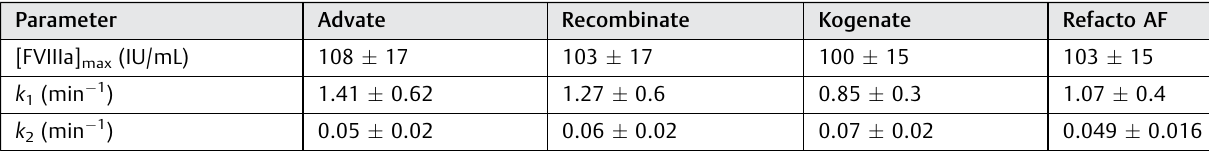
Table 2 Best- fi t kinetic rate constants derived from the application of Eq. 2 for FX activation by thrombin-activated FVIII from Advate, Recombinate, Kogenate, and Refacto AF Parameter